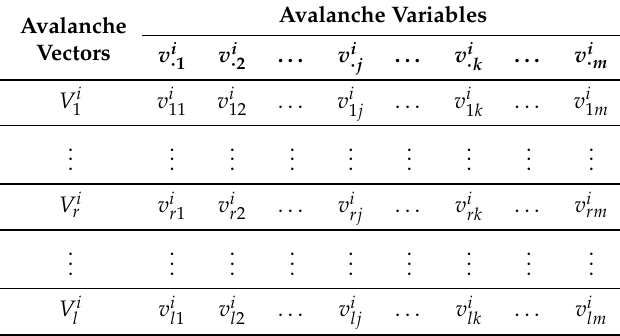
Table 1. SAC matrix H i = ( v i